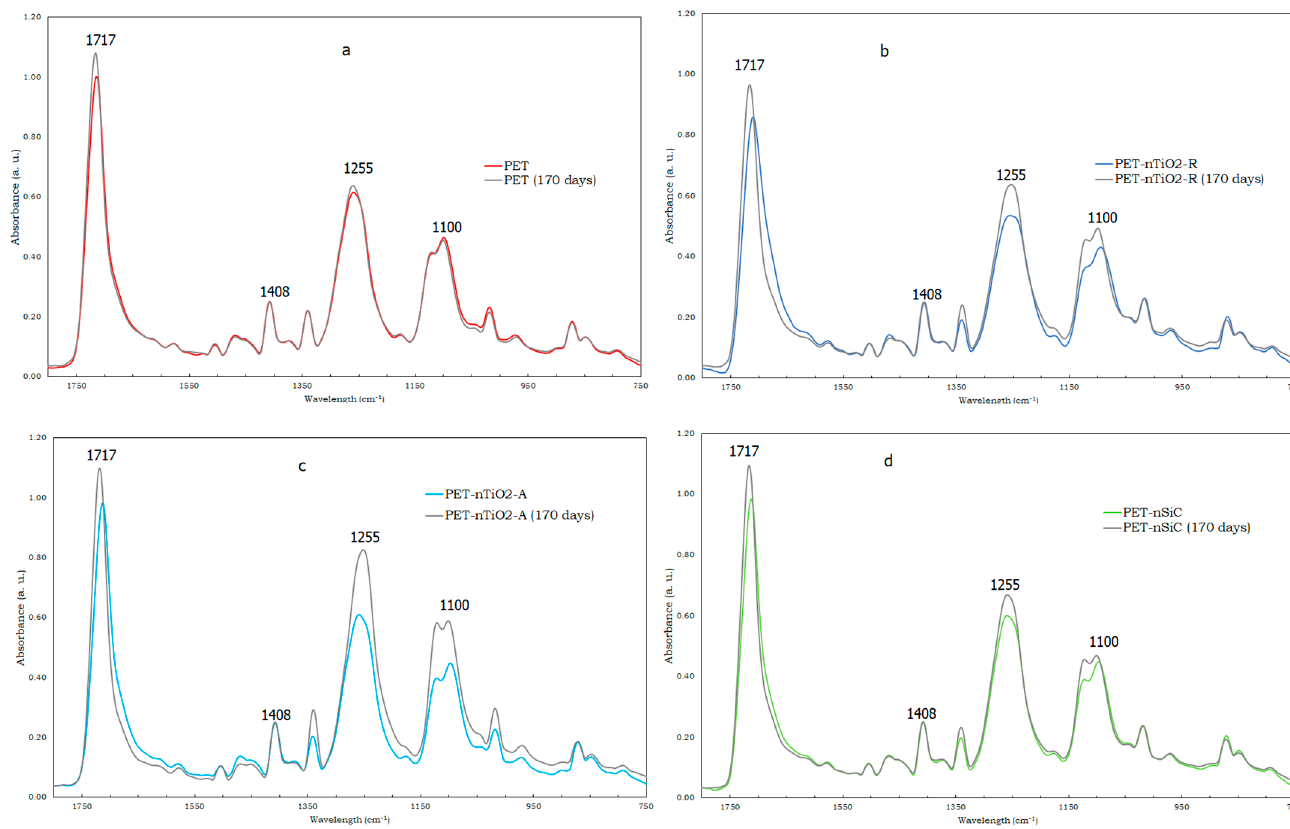
Figure 4. Normalized FTIR–ATR spectra of unexposed and exposed samples after 170 days of ac ‐ celerated exposure: ( a ) pure PET, ( b ) PET ‐ nTiO2 ‐ R, ( c ) PET ‐ nTiO2 ‐ A, and ( d ) PET ‐ nSiC. The 1408 accelerated exposure: ( a ) pure PET, ( b ) PET-nTiO2-R, ( c ) PET-nTiO2-A, and ( d ) PET-nSiC. The cm − 1 band was used for normalization. 1408 cm − 1 band was used for